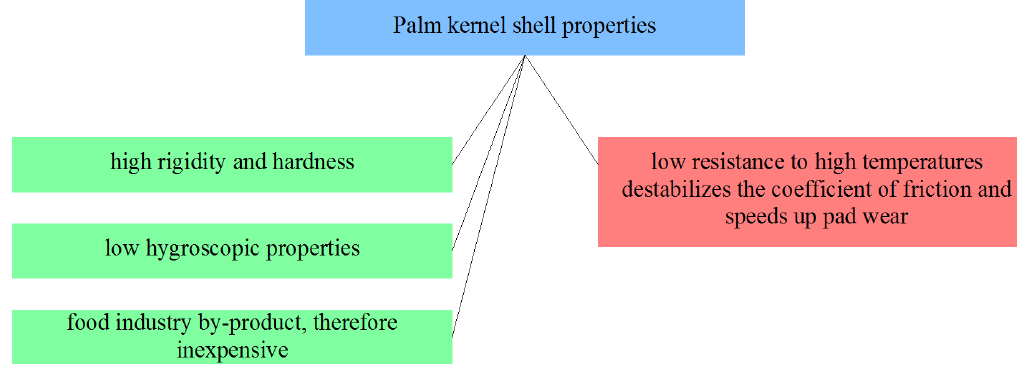
Figure 14: Selected PKS properties from the point of view of applicability in friction materials